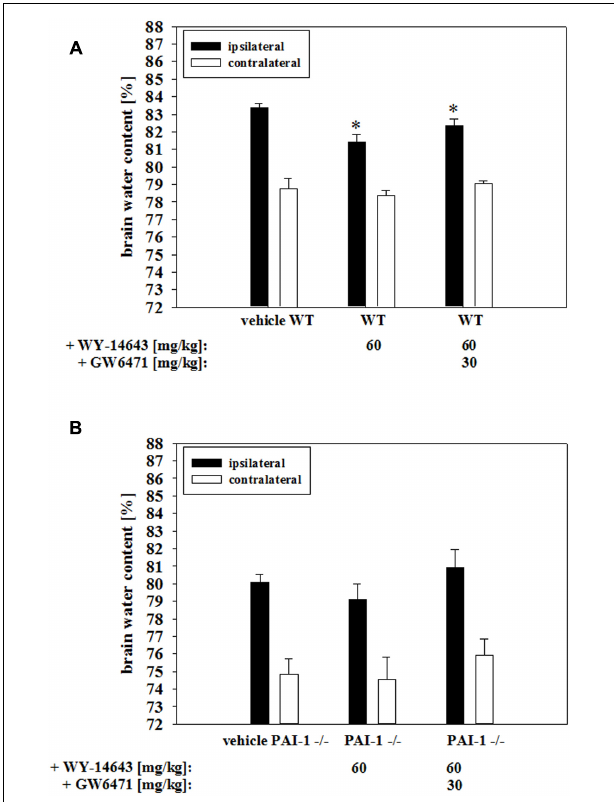
FIGURE 6 | Influence of WY-14643 on brain water content [%] 24 h after controlled cortical impact in a mouse traumatic brain injury model. 60 mg/kg body weight of WY-14643 reduced the increase of brain water content in the ipsilateral brain hemisphere of wild type C57Bl/6 mice significantly. Addition of PPAR α antagonist GW6471 did not reverse the beneficial effects of WY-14643 (A) . Administration of 60 mg/kg body weight WY-14643 did not decrease brain water content of PAI-1 knockout mice (PAI-1 − / − ) after TBI. (B) . Statistical significance was labeled with ∗ ( p < 0.05). Data are presented as means ± SEM (wild type: n = 6–12; PAI-1 − / − : n =